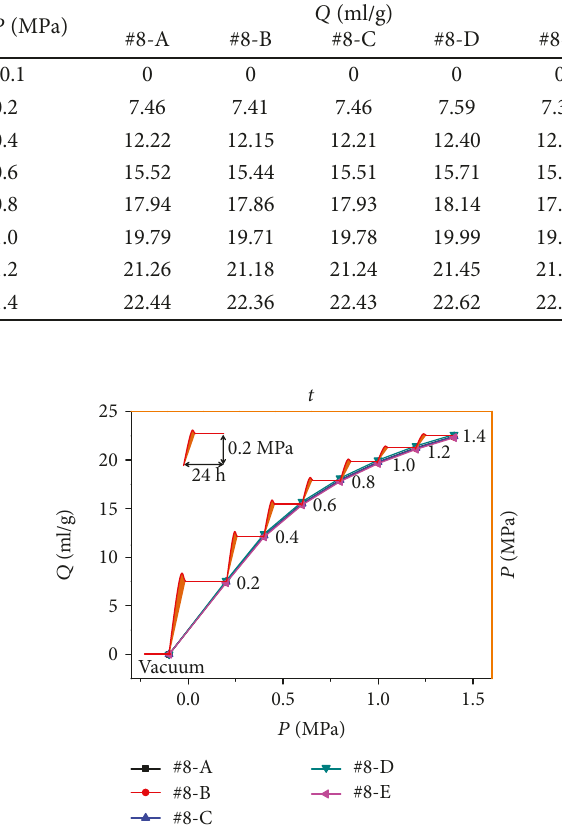
Figure 4: Deformation curves of isogradient pressurized adsorption and gas adsorption capacity of the coal